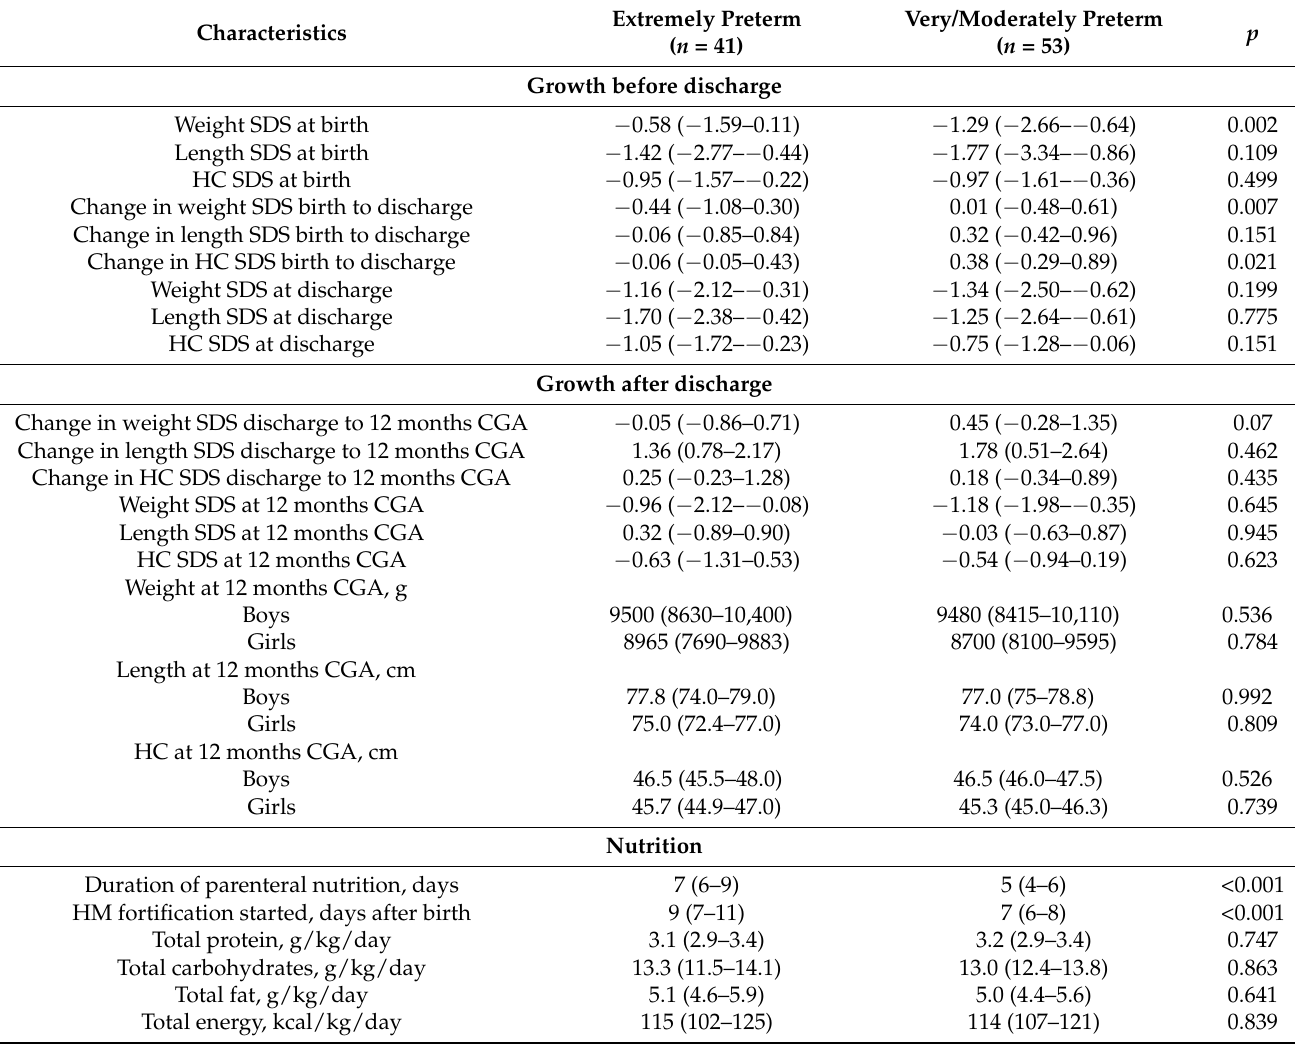
Table 2. Characteristics of growth, nutrition, and